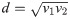
Independent Multisite Modification Model.(a) Target molecule in modified-form I can be in the inactive state BI or active AI state. (b) Dose response curve, f(u, v) when n = 2, 5, 7 for increasing kinase concentration u with vi = 100 and d = 1000 (c-e) Heat maps for H when v1, v2 ∈ [10, 108] with d = 1000, and (c) n = 2, dashed line used to denote region where d=v1v2. (d) n = 4, vi = 100 for all i ≥ 3, similarly with (e) n = 7.